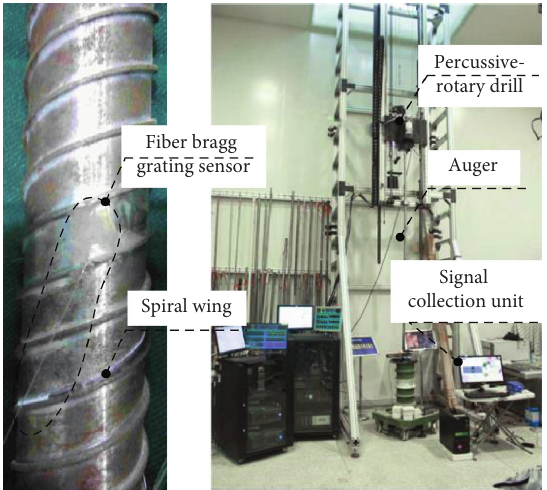
Figure 9: The drilling impact stress transfer characteristics’ test system.